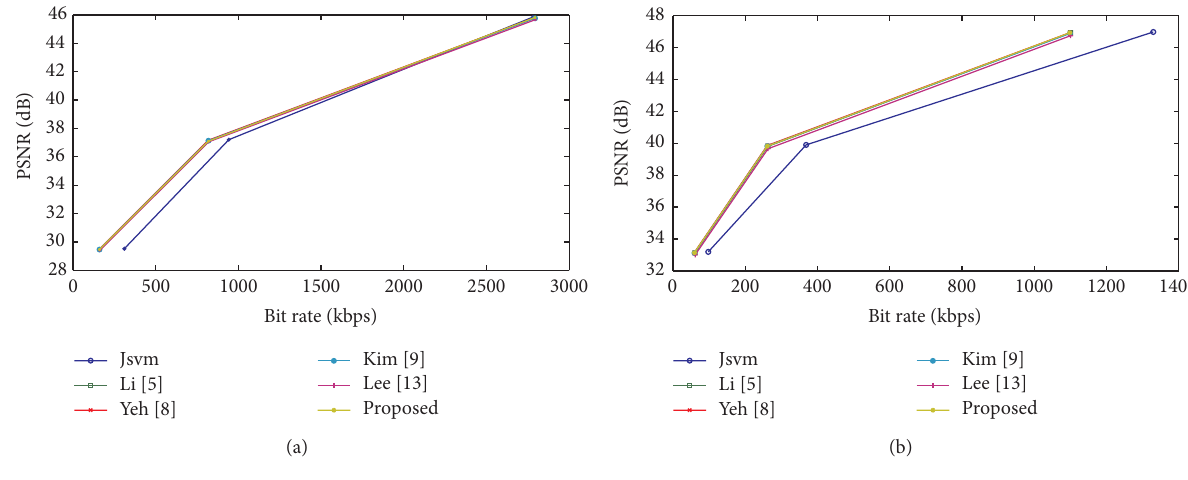
Figure 5: Rate distortion curves for (a) Bus and (b) Crew.